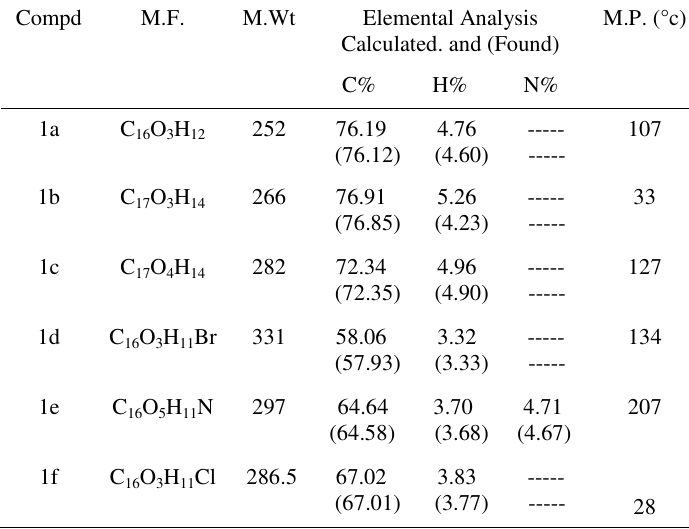
Table-1. Elemental analysis data of title compounds